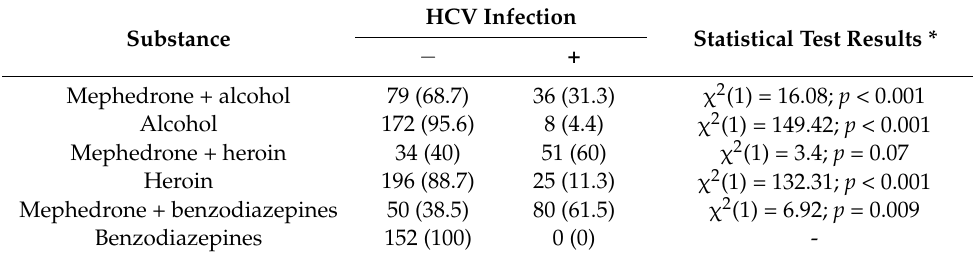
Table 2. The incidence of HCV infection in the compared